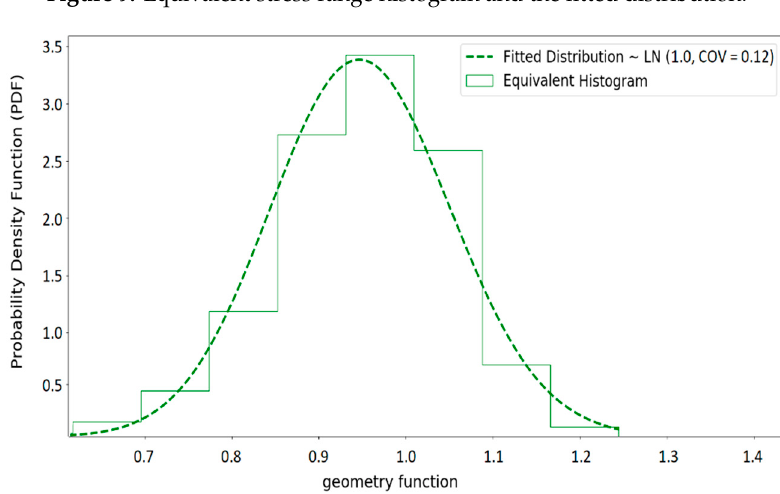
Figure 10. Equivalent geometry function histogram and the fitted distribution